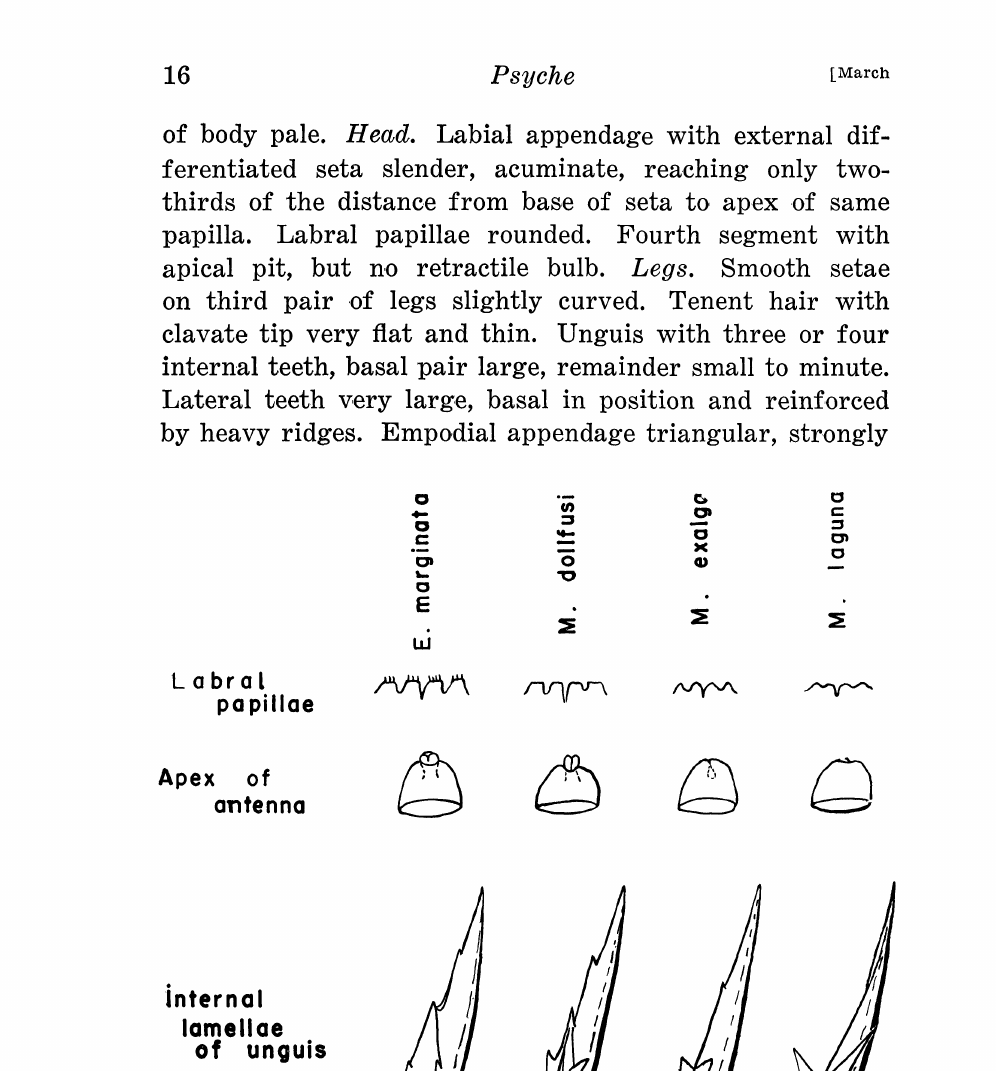
Text-figure 1. Representation of the condition of various organs in the species of Mesentotoma and in Entomobrya